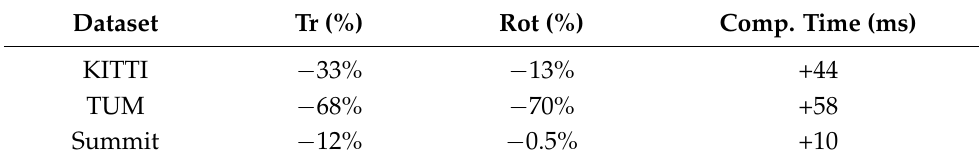
Table 8. The pipeline effect on